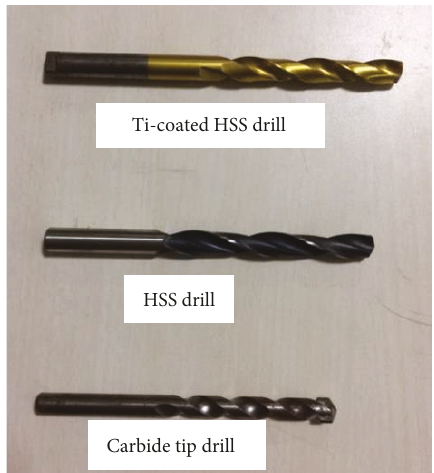
Figure 3: Types of drill bits used for the drilling operation.